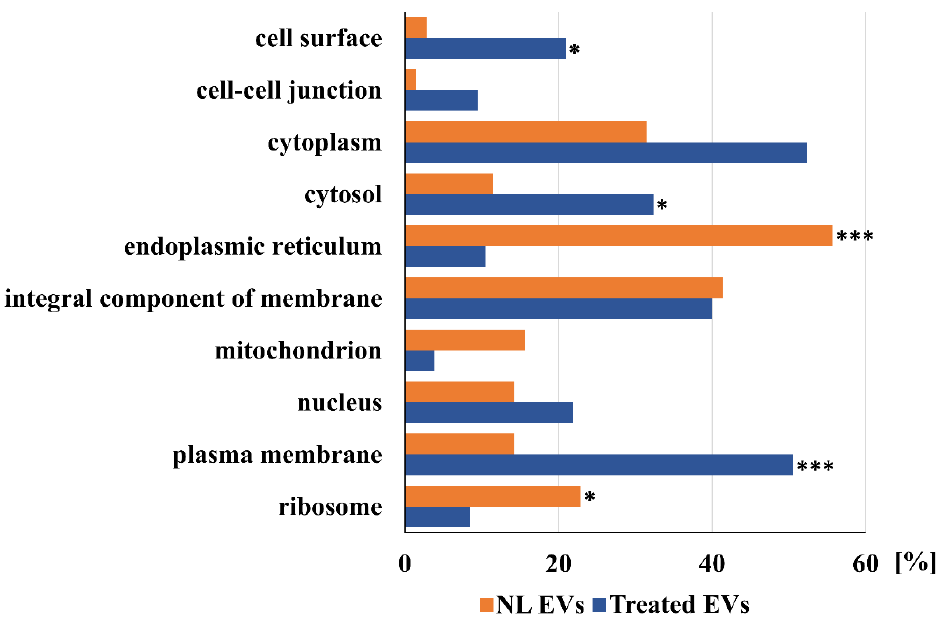
Figure 1. Comparison of unique proteins of normal (NL EVs) and acetaminophen treated (Treated EVs) liver EVs annotated according to their cellular component. For the enrichment of GO terms the threshold was set at the p < 0.001. Statistically significant enriched GO terms are marked according to the obtained p -value: * p < 0.001, *** p < 0.00001.